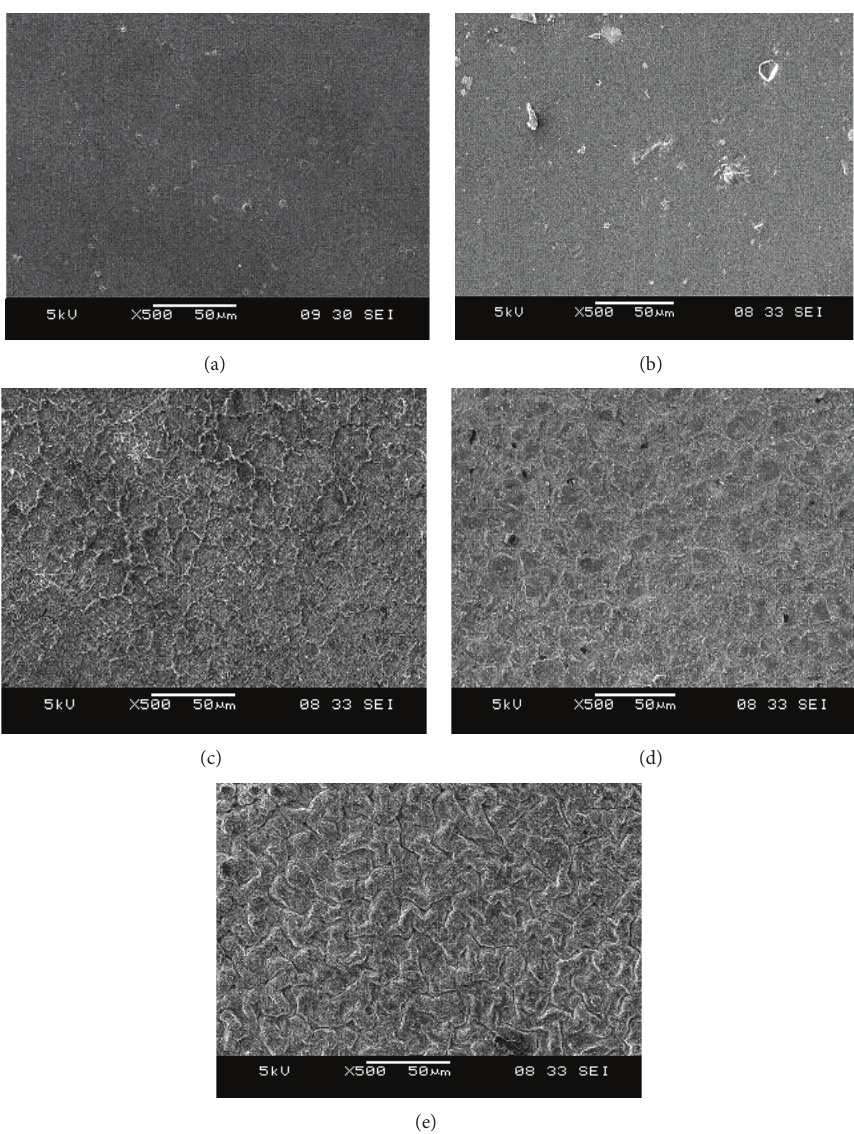
Figure 4: SEM images of (a) chitosan film, (b) chitosan-spinach blend film (95 :5), (c) chitosan-spinach blend film (90: 10), (d) chitosan- spinach blend film (85: 15), and (e) chitosan-spinach blend film (80: 20).